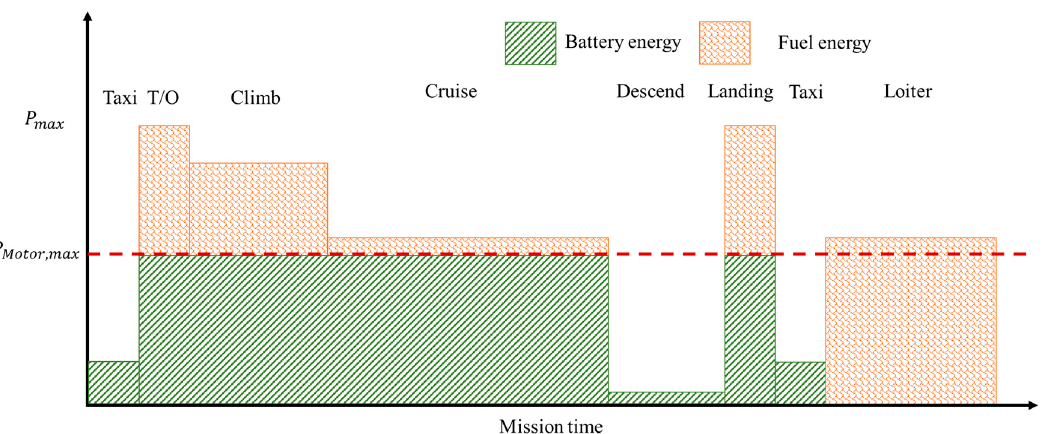
Figure 5. Definition of battery operation strategy: maximum battery energy usage depending on EM power sizing.